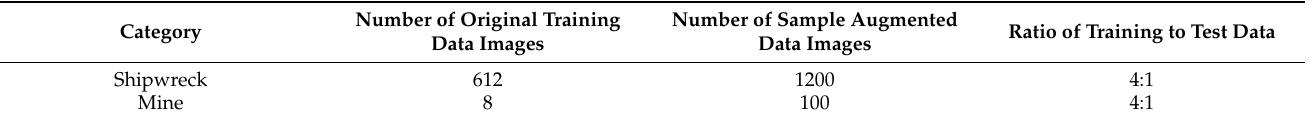
Table 1. Details of the underwater-target data